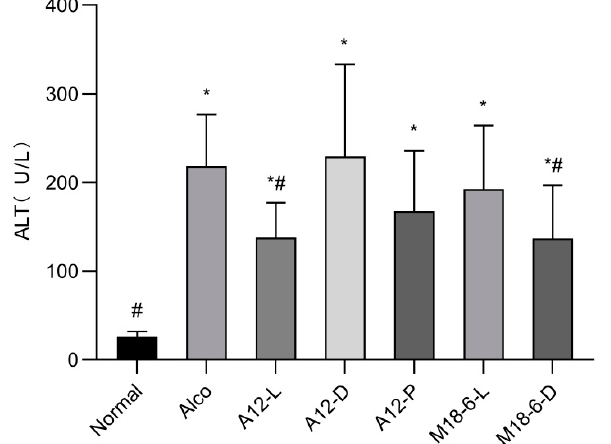
Figure 4. Serum ALT level in mice. Compared with normal group ( p < 0.05) *, compared with Alco group ( p < 0.05) #. ALT: alanine transaminase. Normal: normal saline-fed; Alco: alcohol-fed